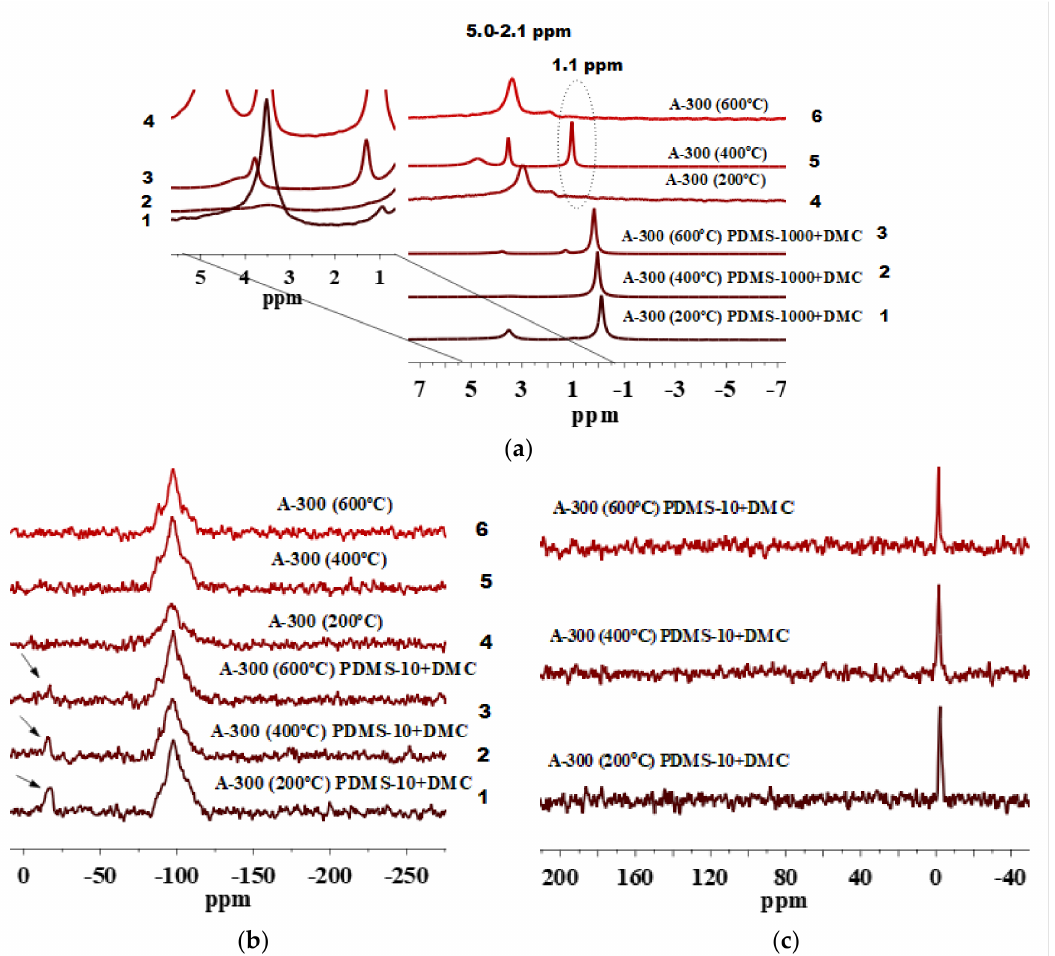
Figure 8. ( a ) 1 H MAS NMR, ( b ) 29 Si NMR, and ( c ) 13 C CP/MAS NMR spectra of A-300 preheated at 200, 400, and 600 ◦ C and modified by